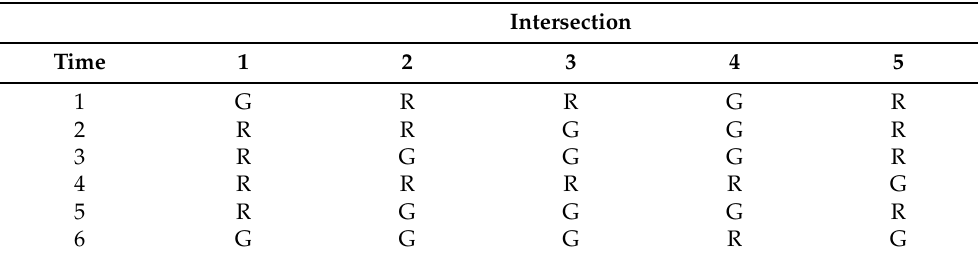
Table 2. Sample sequence of traffic lights realized at each intersection for the MITL specification ϕ 1 = (cid:51) [ 0,6 ] ( x 4 ≤ 10 ) . The letters ‘R’ and ‘G’ represent ‘red’ and ‘green’ signals,